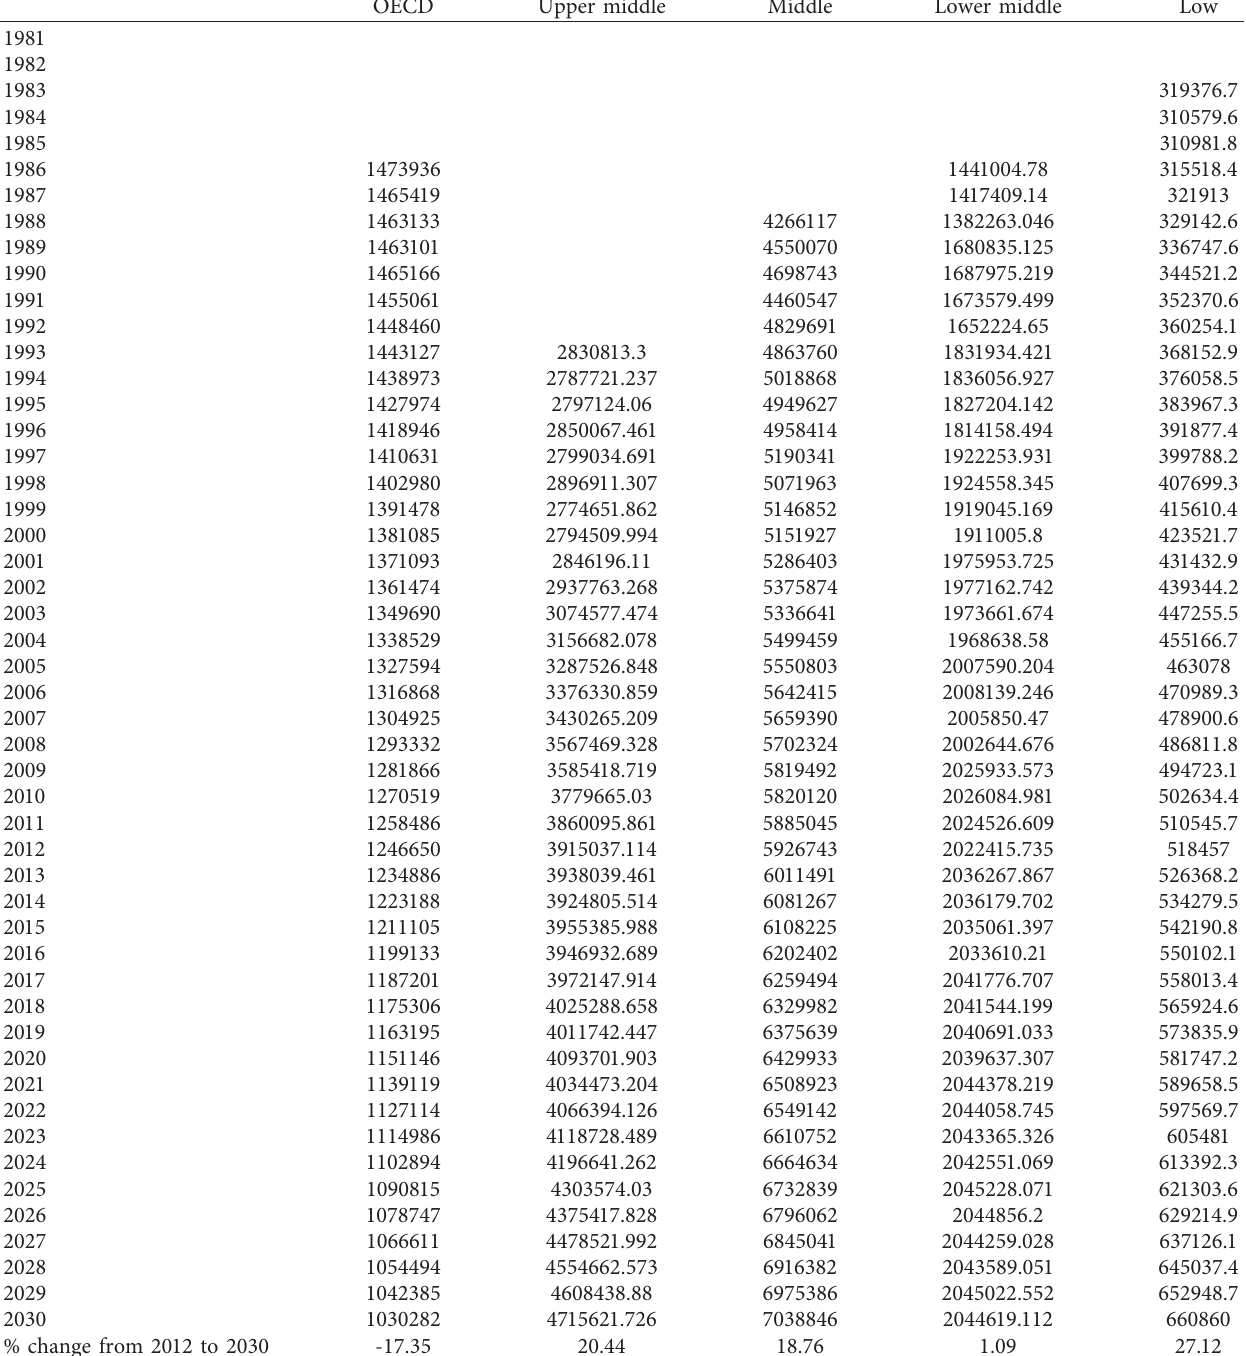
Table 4: Forecasted values of methane emission (in kt CO 2 equivalent) under the BJ method. OECD Upper middle Middle Lower middle